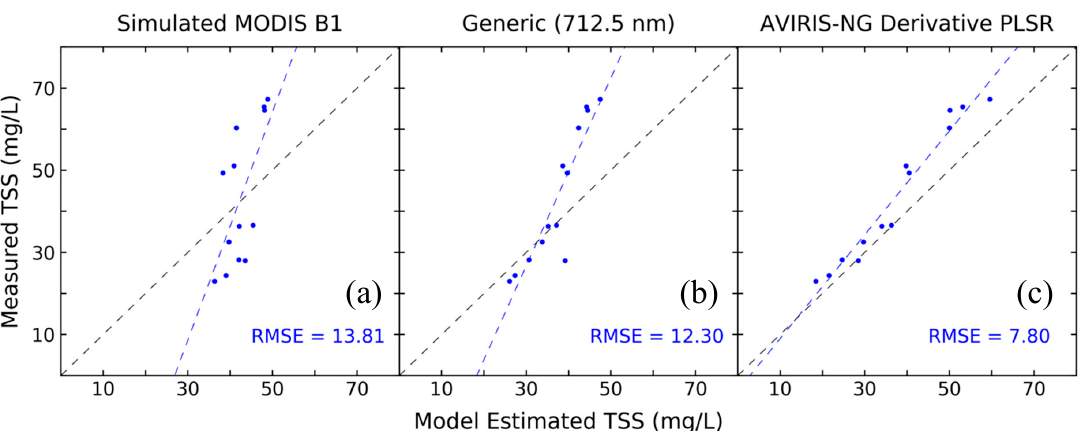
Figure 5. Validation results for total suspended solids (TSS, mg/L) retrieval from the San Francisco Bay–Delta Estuary PRISM dataset with the ( a ) simulated MODIS band 1 regression model, ( b ) generalized model at 712.5 nm [18], and ( c ) first derivative-based PLSR model. The PLSR model shows significantly better performance, with a lower RMSE and a line of best fit that has better agreement with the 1:1 line. Additional error metrics are listed in Table 3.